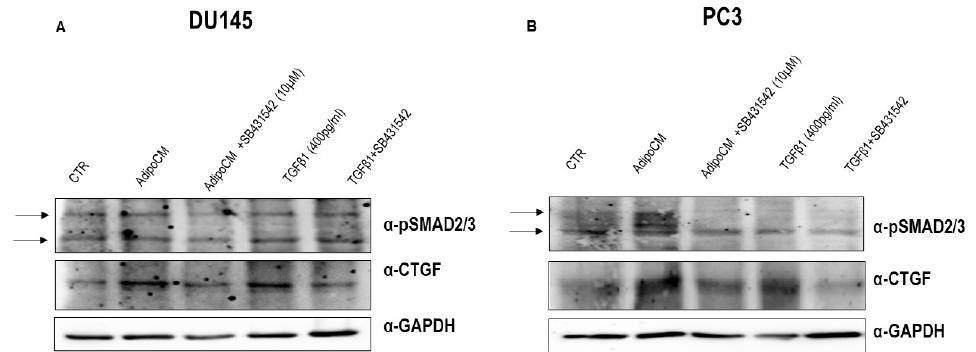
Figure 4. CTGF protein expression is reduced by TGF β 1 receptor inhibitor. ( A , B ) PCa cell lines were seeded (2 × 10 5 cells/well) in multi-well plates and incubated with a medium containing 0.25% BSA or AdipoCM, human recombinant TGF β 1 (400 pg/mL) and SB431542 (10 μ M) alone or in combination. Cells were solubilized and protein samples analyzed by Western blot with CTGF and pSMAD2/3 antibodies. GAPDH antibody was used for normalization. Blot results were revealed by ECL and autoradiograph.